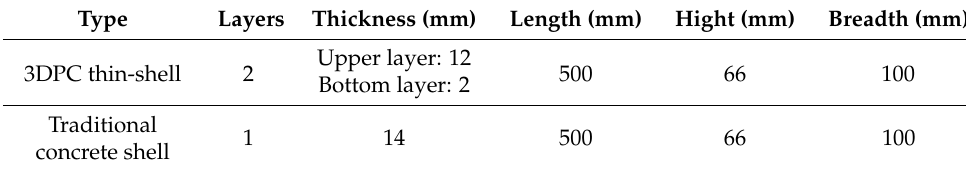
Table 3. Dimensions of thin-shell